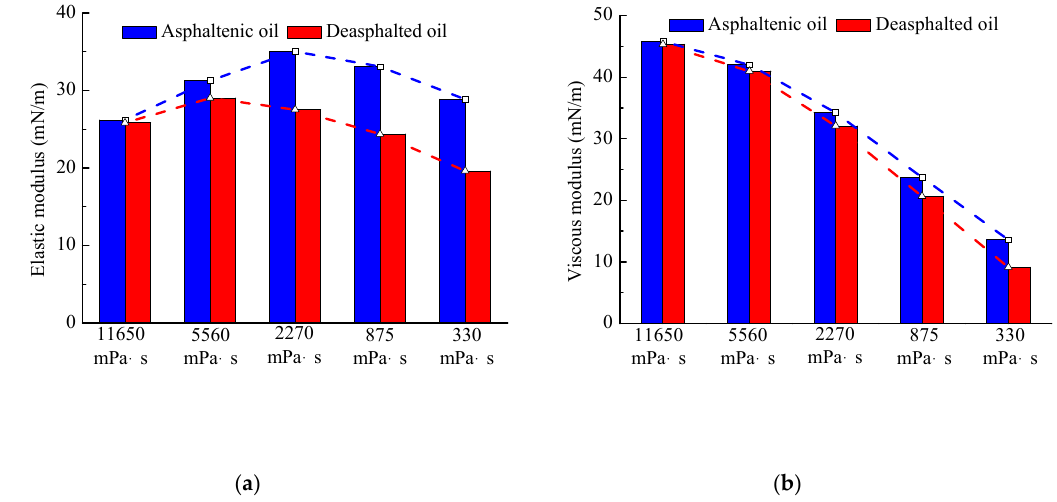
Figure 13. Effect of asphaltene on the elastic modulus and viscous modulus at different viscosities: ( a ) elastic modulus; ( b ) viscous modulus.